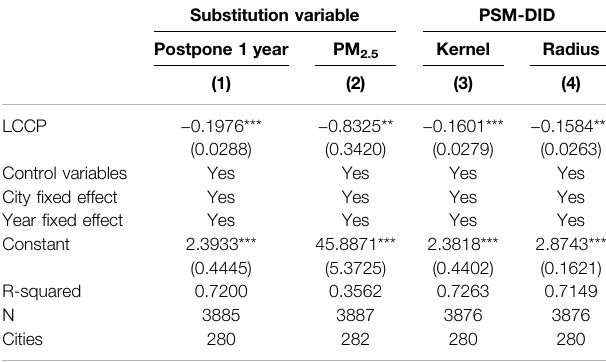
TABLE 7 | Robustness analysis: substitution key variables and